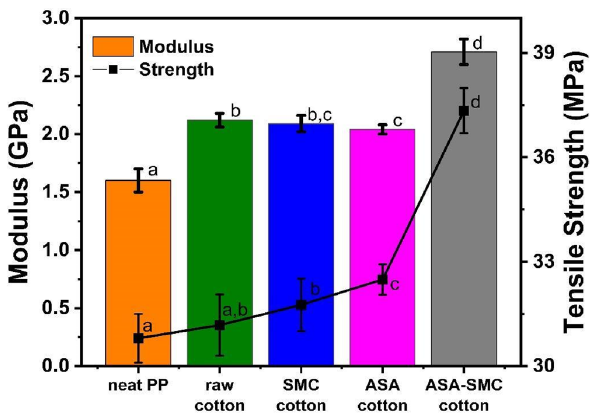
Figure 3. Tensile strength and modulus of neat PP and PP composites reinforced with 10% white cotton (raw cotton, SMC-cotton, ASA-cotton, and ASA-SMC-cotton). Different letters (a-d) indicate significant differences (p < 0.05) using Student’s t-test for both strength and modulus.